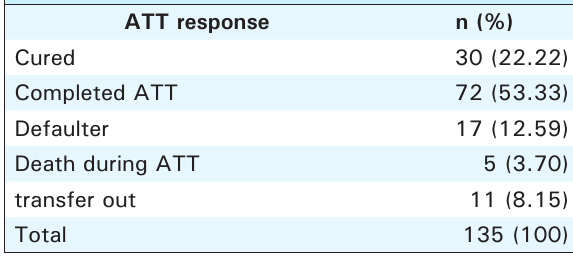
Table 5. Distribution of subjects by ATTresponse.